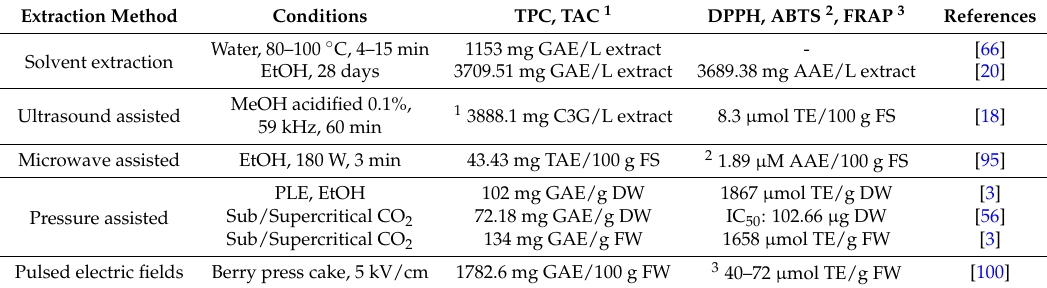
Table 5. Antioxidant content and capacity of Vaccinium myrtillus extracts obtained with different